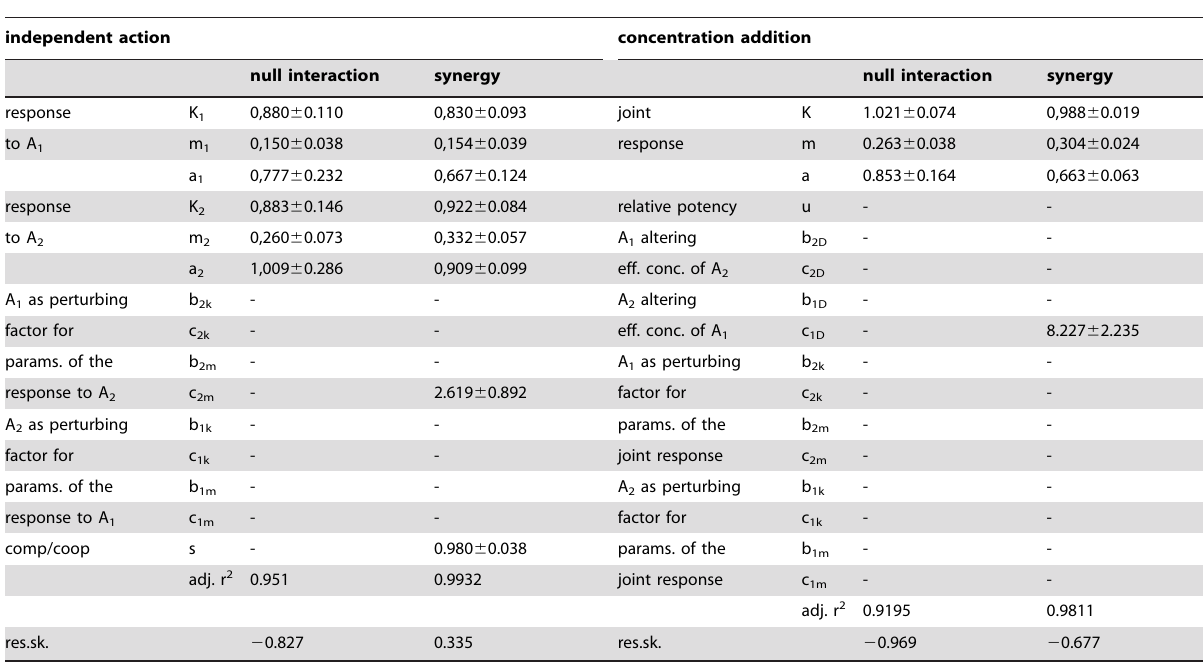
Table 6. Antioxidant joint action of ascorbic acid (A 1 ) and trolox (A 2 ) on crocin